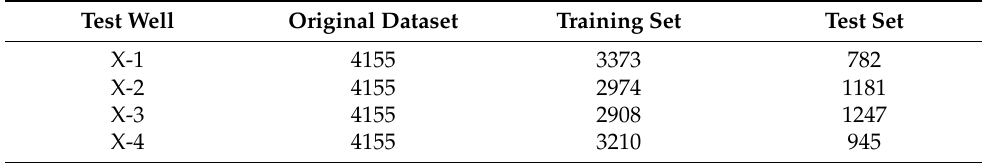
Table 3. Data splitting for training and test set.